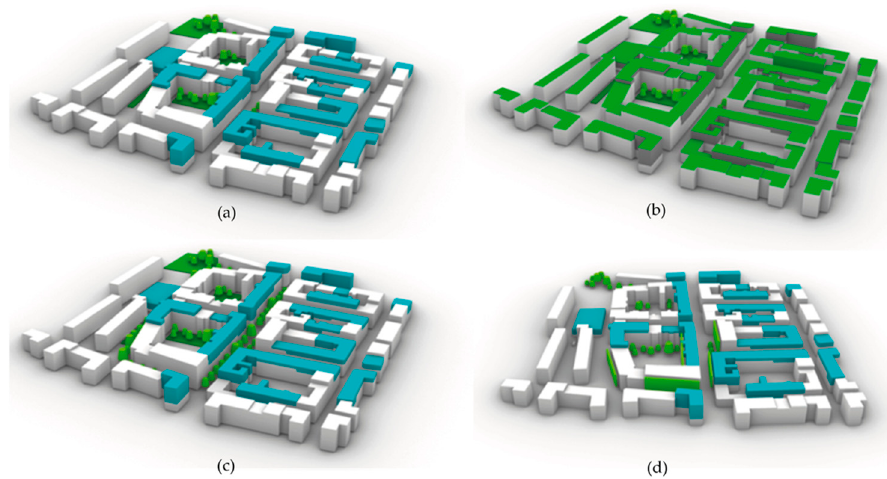
Figure 11. The 3D model of the smaller sample area for the microclimate simulations: for the initial densification scenario ( a ), for the densification scenario with green roofs ( b ), with additional trees at street level ( c ), and with green facades in a south-western street block ( d ).